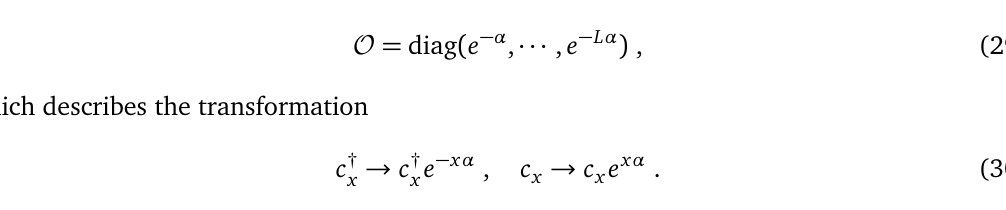
arises from non-reciprocal hopping te ± α while o